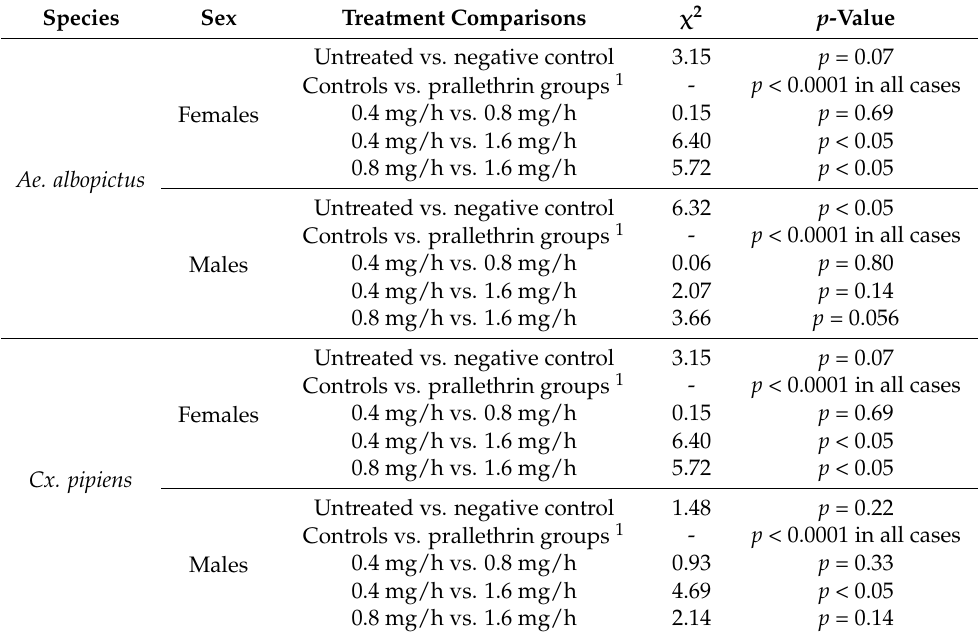
Table 4. Treatment effects on long-term mortality for female and male Ae. albopictus and Cx. pipiens across the five treatment groups.